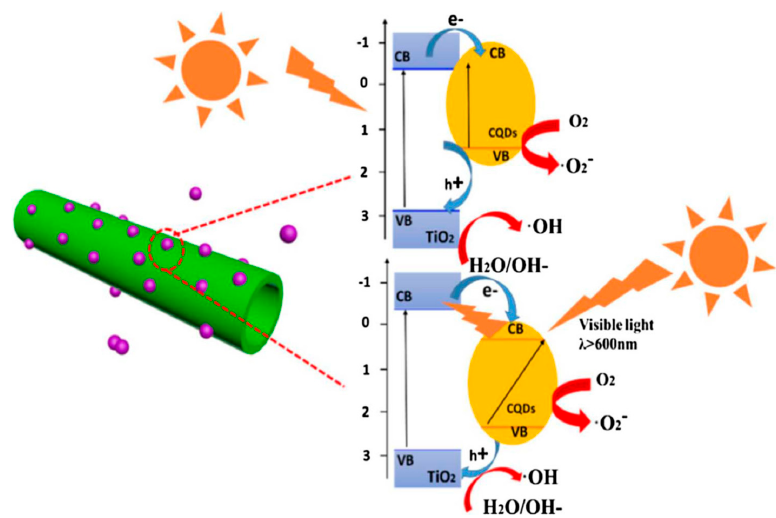
Figure 14. Schematic illustration indicating the photocatalysis mechanism of the CQDs/TNTs